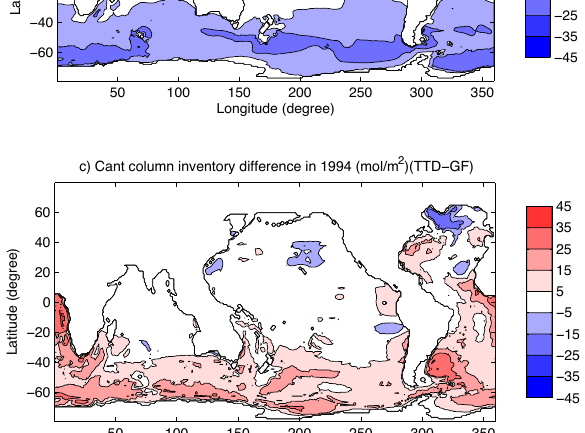
18 % and 33 % lower in the North Atlantic Ocean and the Southern Ocean, respectively. It is likely that the CCSM un- derestimates the C ant in these two regions. The mixing in the CCSM is relatively weak at high latitudes, especially in the Southern Ocean. A previous study has suggested that the weak formation and ventilation of Antarctic Intermedi- ate Water and mode waters in the Southern Ocean in the CCSM may cause a weak oceanic carbon sink (Thornton et al., 2009). If we include the Atlantic sector of the